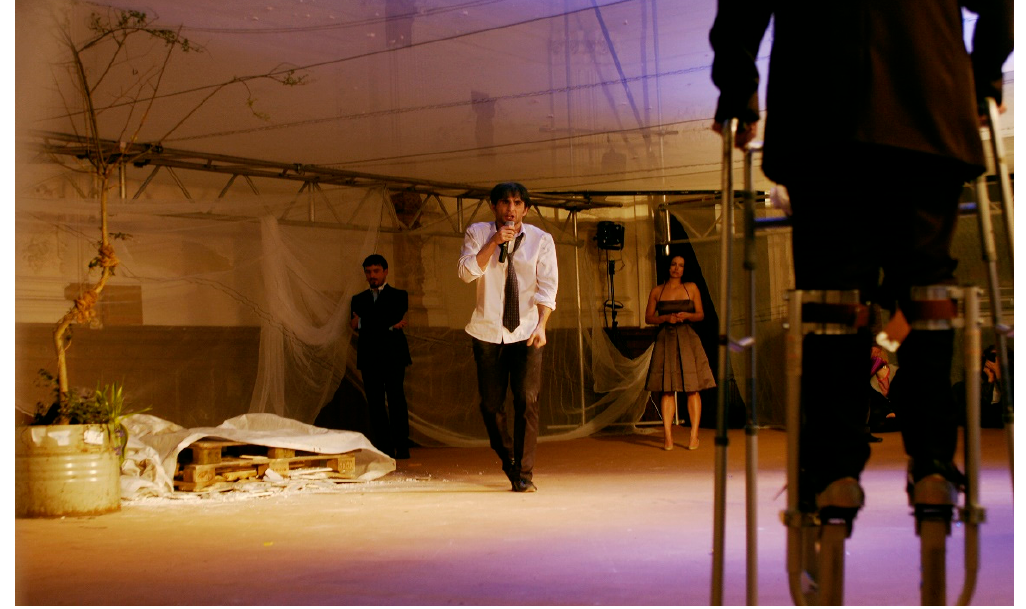
Figure 2. Nathan with microphone in hand (photo by Ute Langkafel, 2009).